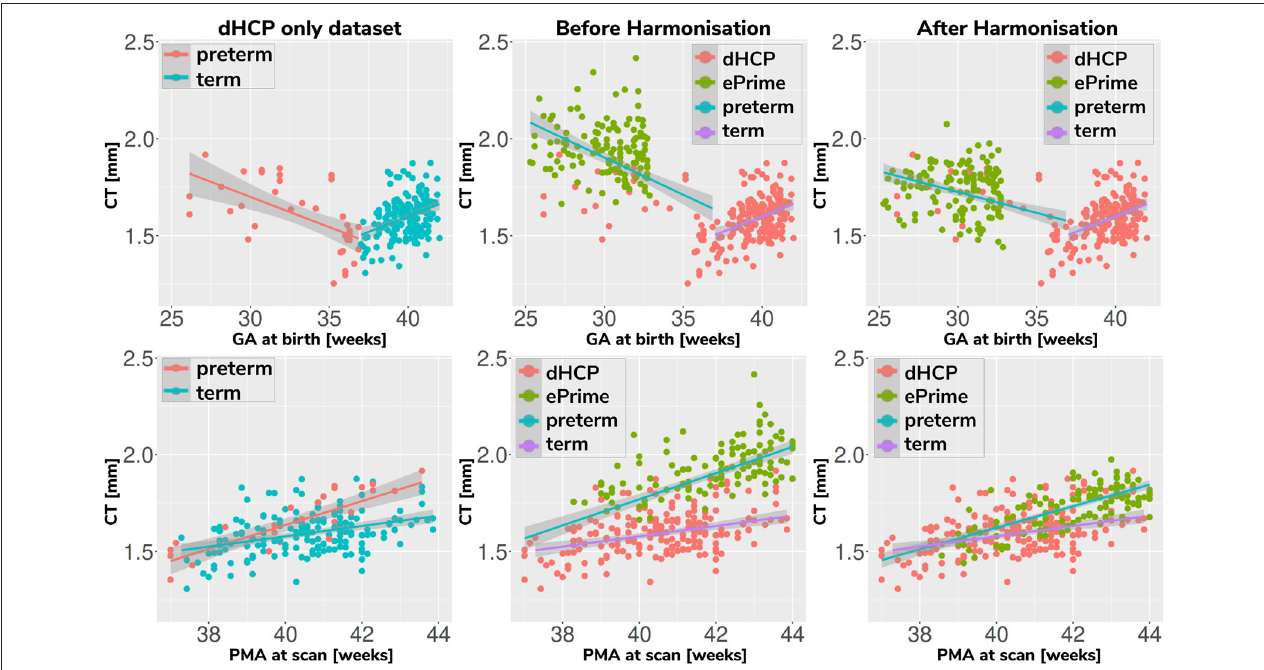
FIGURE 11 | Mean cortical thickness measures in our dHCP dataset (first column), and in both cohorts before (second column) and after (third column) harmonizing the tissue segmentation maps. The first row plots the cortical thickness measures against GA, while the second row plots the cortical thickness measures against PMA, with individual regression lines on top.